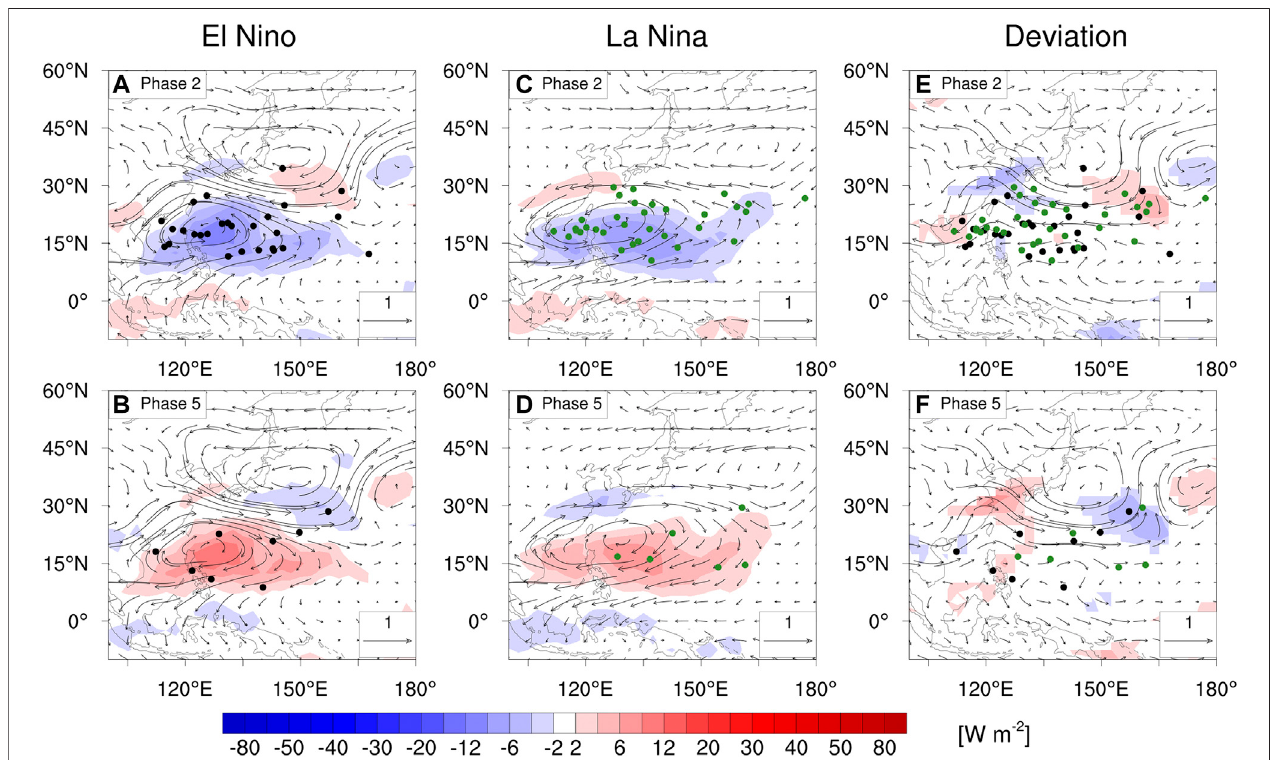
FIGURE 8 | The composition of wind (m/s, vector) at 850 hPa and OLR(W m − 2 , shaded) with the period of 20 – 30 days for El Niño years (A – B) and 50 – 70 days for La Ninayears (C – D) and their difference (El Niño minus La Niña) fi elds (E – F) based on the phase ofthe EAP index. The differences passing the 95% con fi dence level are plotted. The black (green) dots represent the positions of MTC genesis in El Niño (La Niña) summers.